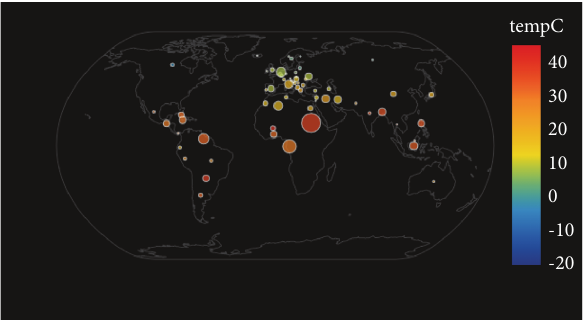
Figure 7: The relationship of humidity with COVID-19